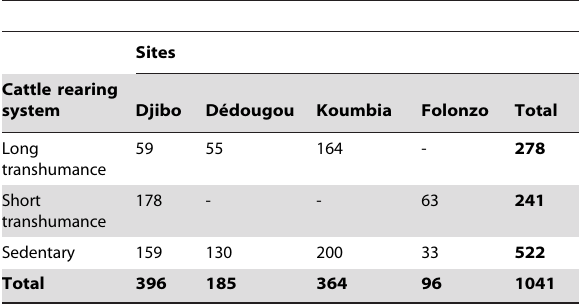
Table 1. Distribution of sampled animals in sites according to cattle rearing